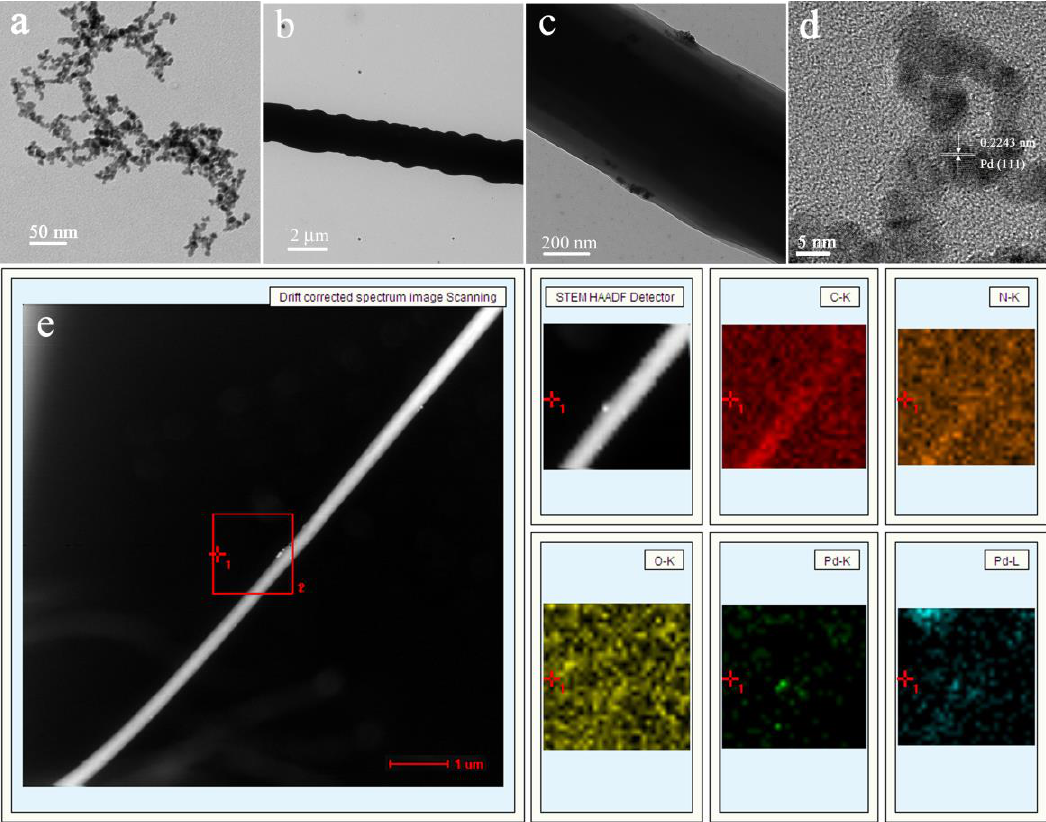
Figure 3. TEM images of the synthesized PdNPs ( a ), PEI / PCL fibers at 35:65 weight ratio ( b ) and modified with PdNPs ( c ), high resolution of PdNPs ( d ), and C / N / O / Pd elemental mapping ( e ) of PEI / PCL@PdNPs composites. The scale size of elemental mapping is 1.5 µm.